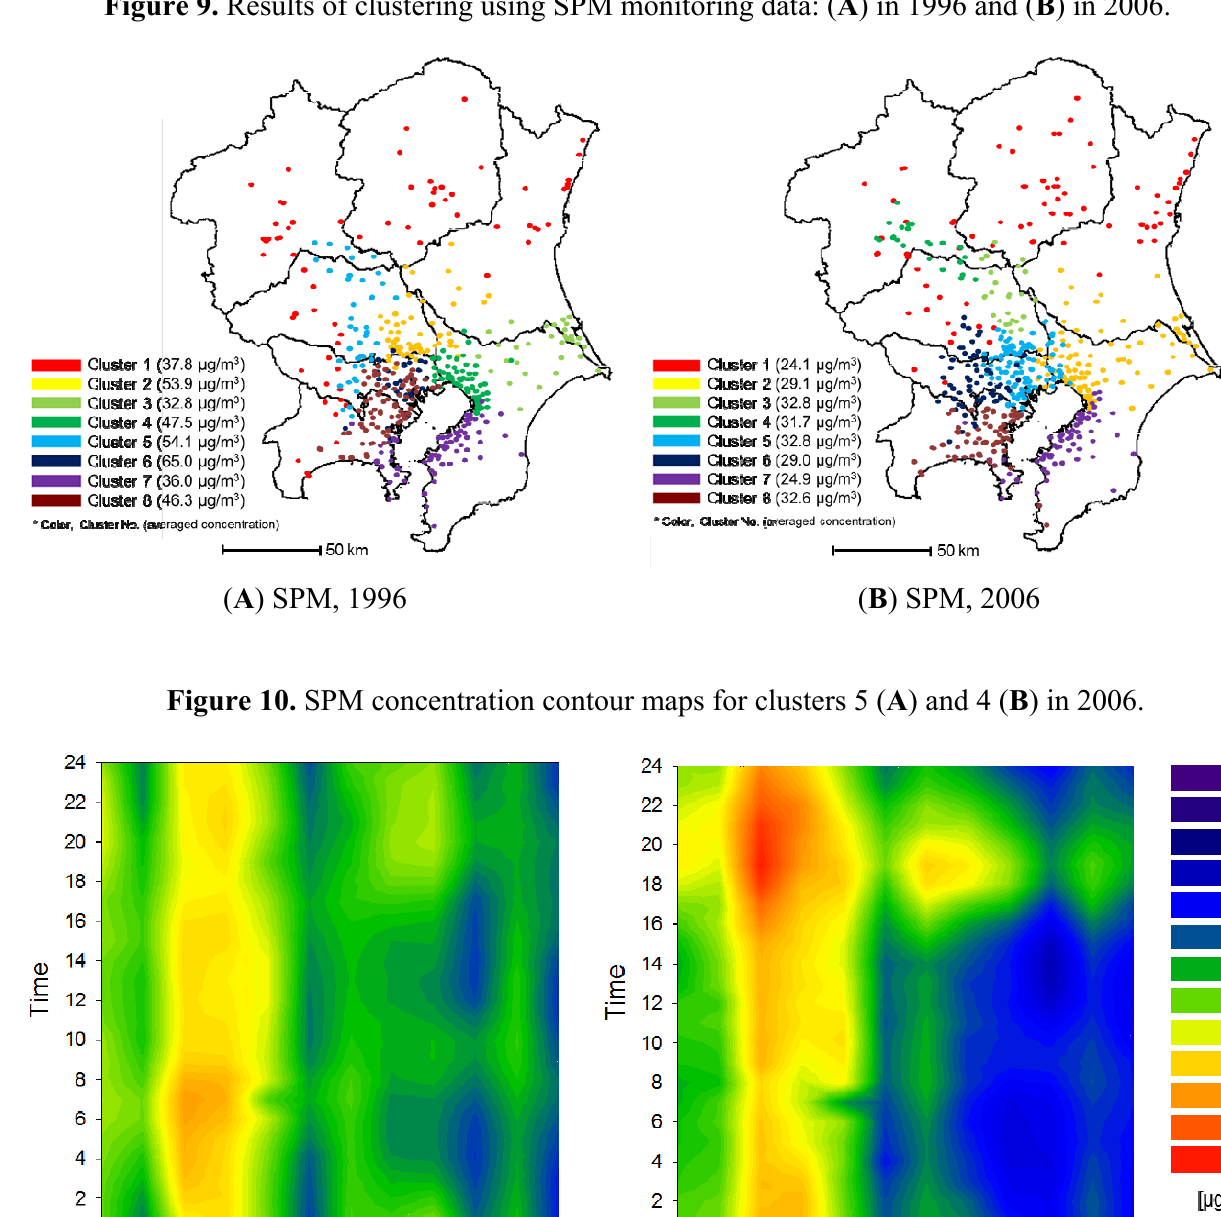
Figure 9. Results of clustering using SPM monitoring data: ( A ) in 1996 and ( B ) in 2006.